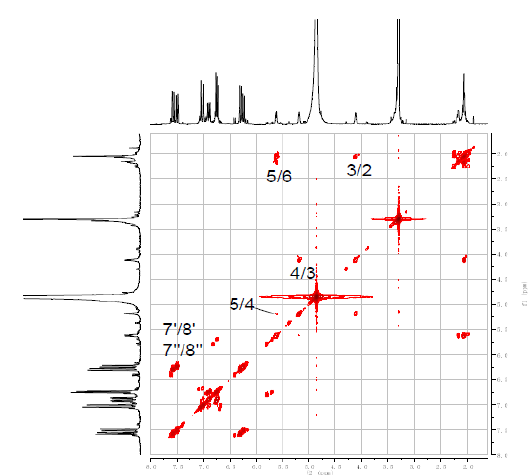
Figure 4. 1 H- 1 H COSY spectrum of compound 3